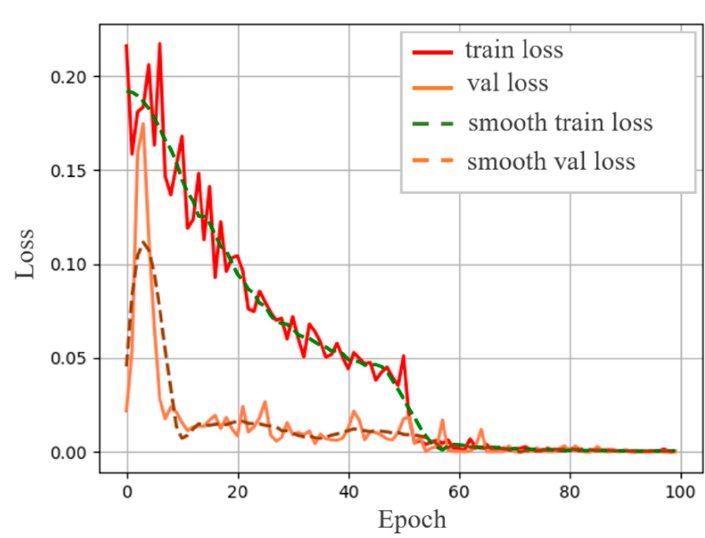
Figure 5. Convergence speed of MobileNetV2 during the training process.